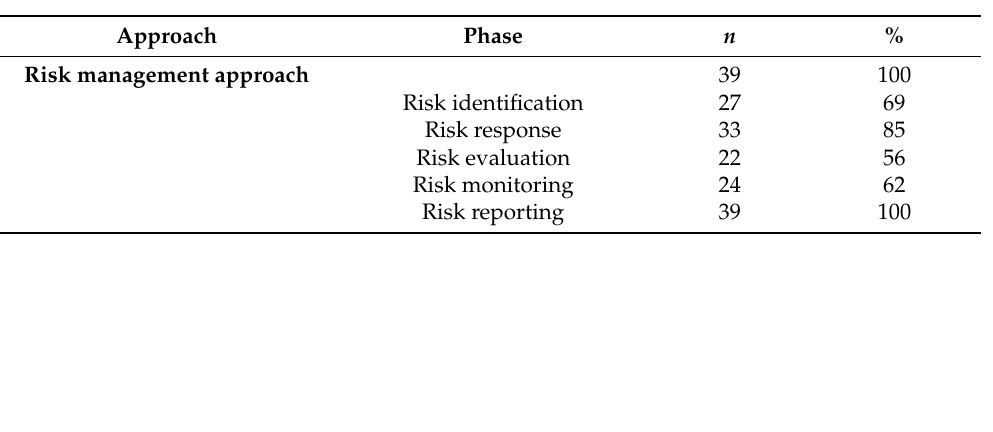
Table 1. Category 1: Risk management